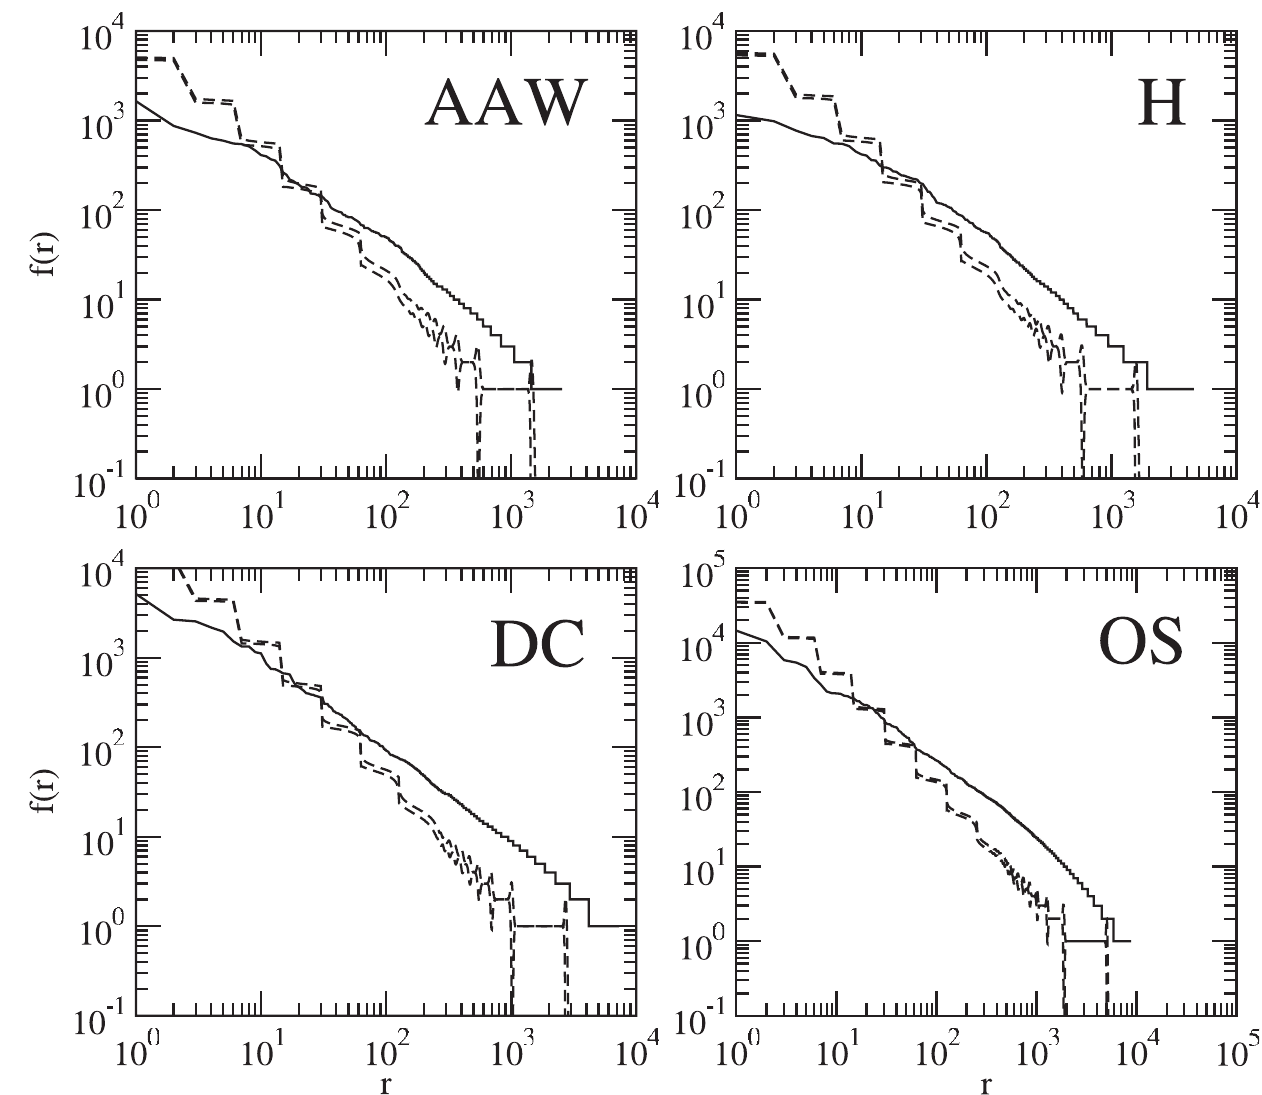
Figure 1. The rank histograms of English texts versus that of random texts ( RT 1 ). A comparison of the real rank histogram (thin black line) and two control curves with the 3 s upper and lower bounds of the expected histogram of a random text of the same length in words (dashed lines) involving four English texts. f ( r ) is the frequency of the word of rank r . For the random text we use the model RT 1 with alphabet size N ~ 2 . The expected histogram of the random text is estimated averaging over the rank histograms of 10 4 random texts. For ease of presentation, the expected histogram is cut off at expected frequencies below 0 : 1 . AAW: Alice’s adventures in wonderland . H: Hamlet . DC: David Crockett . OS: The origin of species .